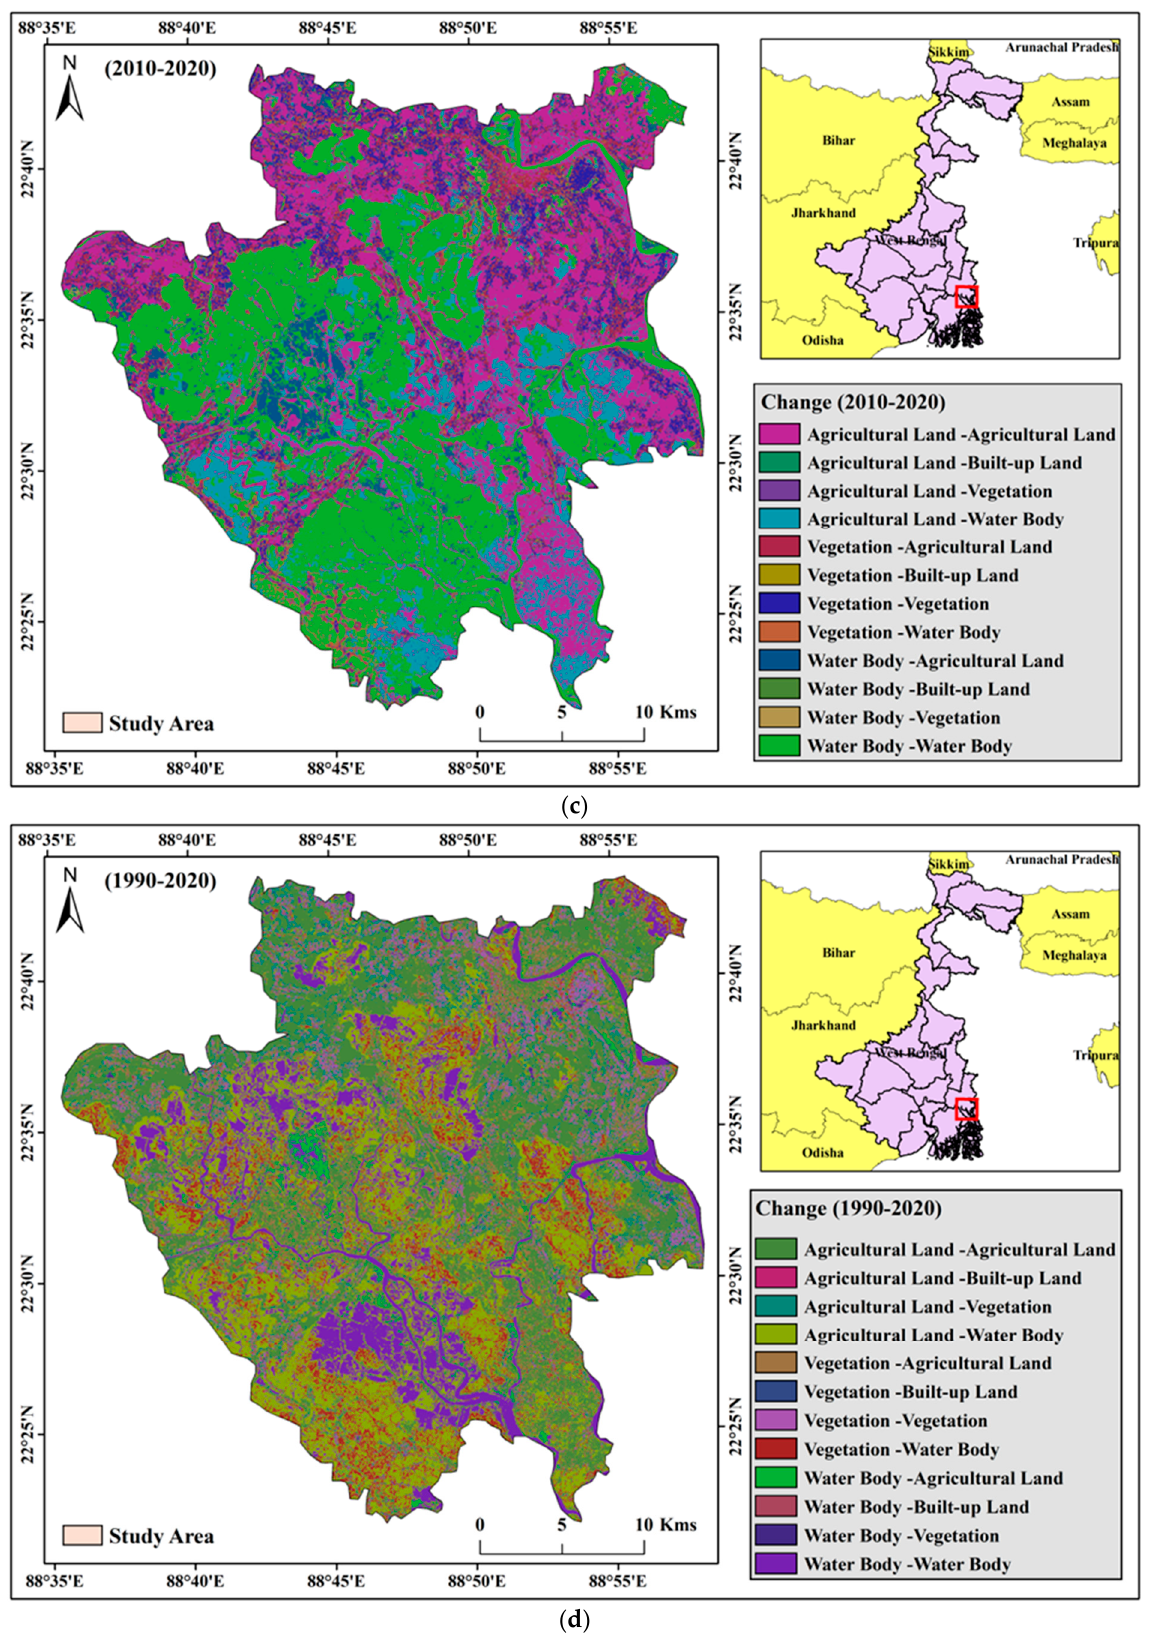
Figure 7. Change detection analysis of different time periods. ( a ) 1990–2000; ( b )